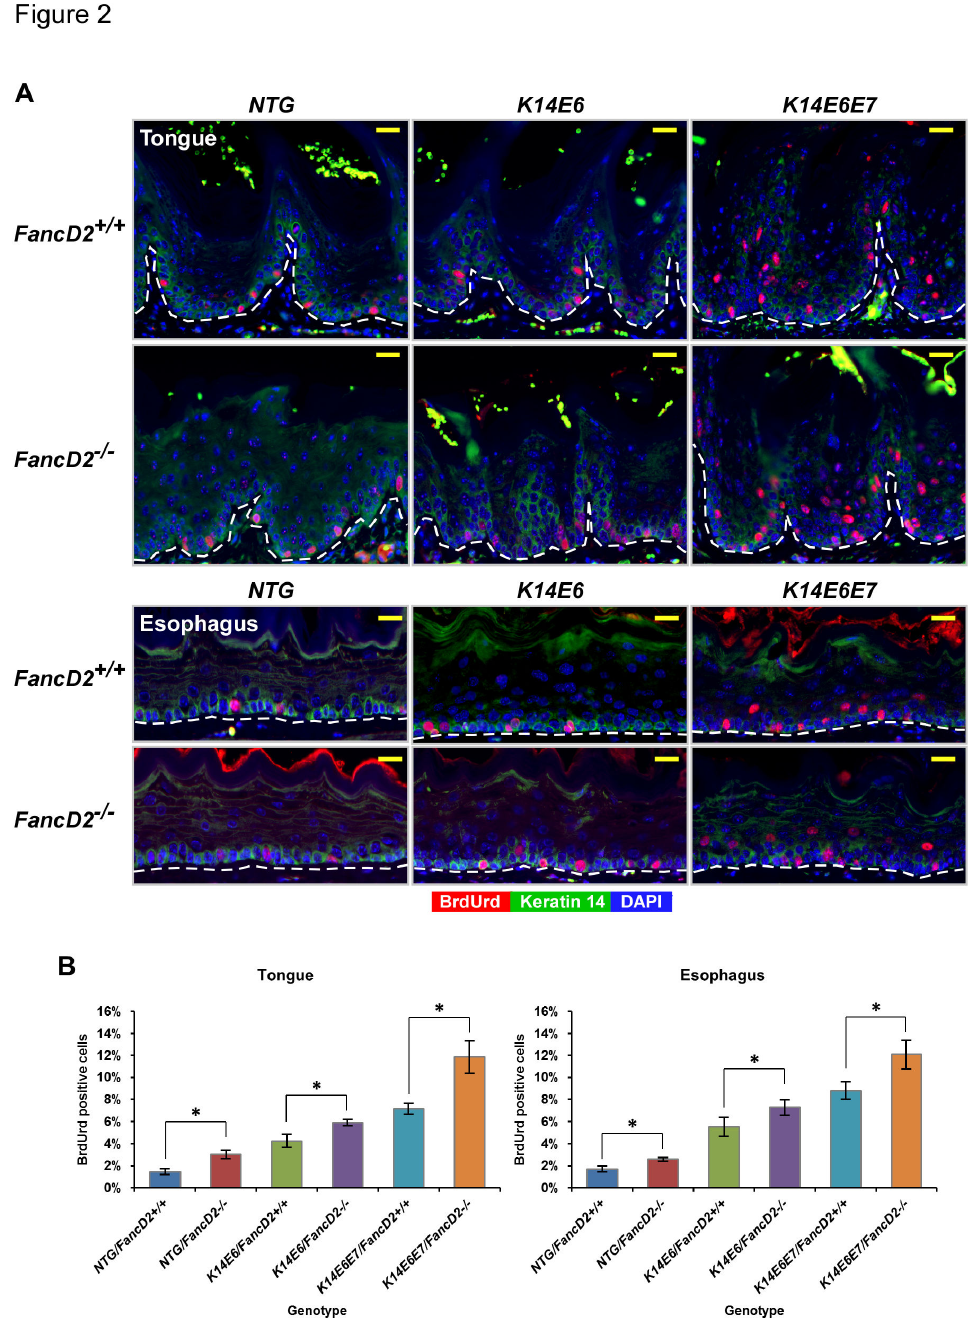
Figure 2. Examination of roles of HPV16 E6 and E7 on cell proliferation under the deficiency of fancD2 gene. A , to score the newly synthesized DNA at the epithelial layers of the tongue and esophagus tissues, mice were intraperitoneally injected with BrdUrd before sacrifice and their tissues were stained for anti-BrdUrd (red) and anti-cytokeratin 14 (CK14) protein (green) antibodies. DAPI (blue) is used for a nuclear counterstaining. Scale bar, 20µm. B , at least three mice of each genotype, NTG/ FancD2 +/+ , NTG/FancD2 -/- , K14E6/FancD2 +/+ , K14E6/FancD2 -/- , K14E6E7/FancD2 +/+ , and K14E6E7/FancD2 -/- mice, were selected and ~8 to 10 frames of cells at the epithelial layers of the tongue and esophagus epithelia were quantified for each mouse. The amount of BrdUrd-positive nuclei over the number of total cells was plotted in each case (columns); bars, SD. Asterisk (*) means that the deficiency of fancD2 gene caused a significant increase in DNA synthesis between genotypes ( P <0.05). All statistical comparisons were performed using a two-sided Wilcoxon rank-sum test. doi: 10.1371/journal.pone.0075056.g002 PLOS ONE |